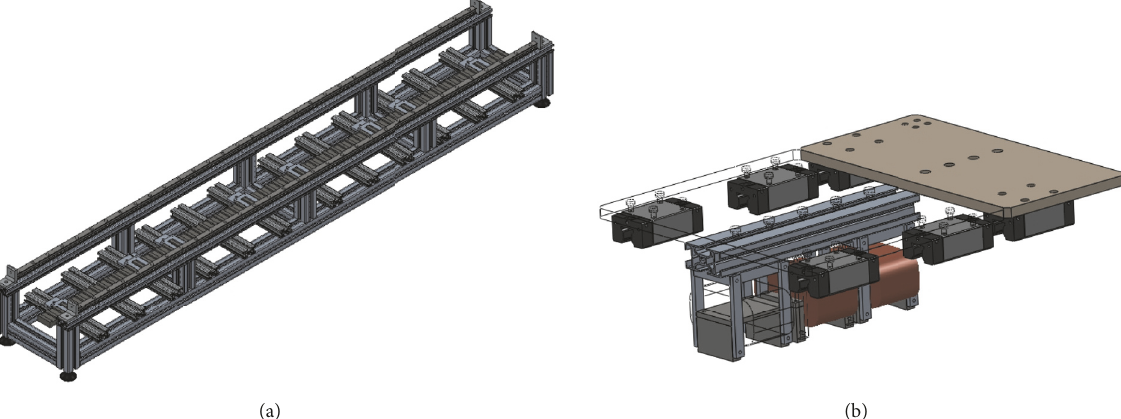
Figure 2: The two main LSRA 3D model assemblies: (a) isometric view of the base parts (longitudinal and transversal bars) and the secondary of magnetic circuit (bar mounted in the middle mounted over transversal bars); (b) perspective view of the platforms subassembly showing the three coils and teeth of the primary of magnetic circuit (some parts shown in wire frame view for reading purposes).